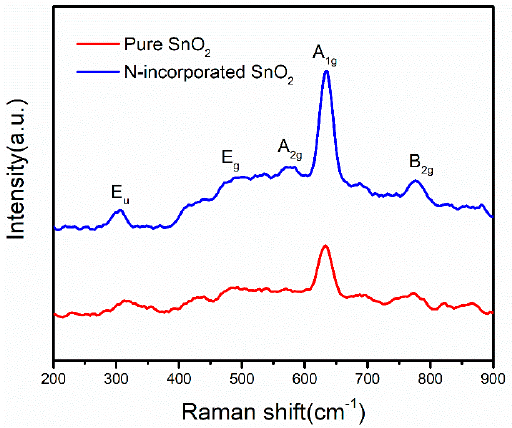
Figure 8. Raman spectra of the N-incorporated SnO 2 and pure SnO 2 samples.